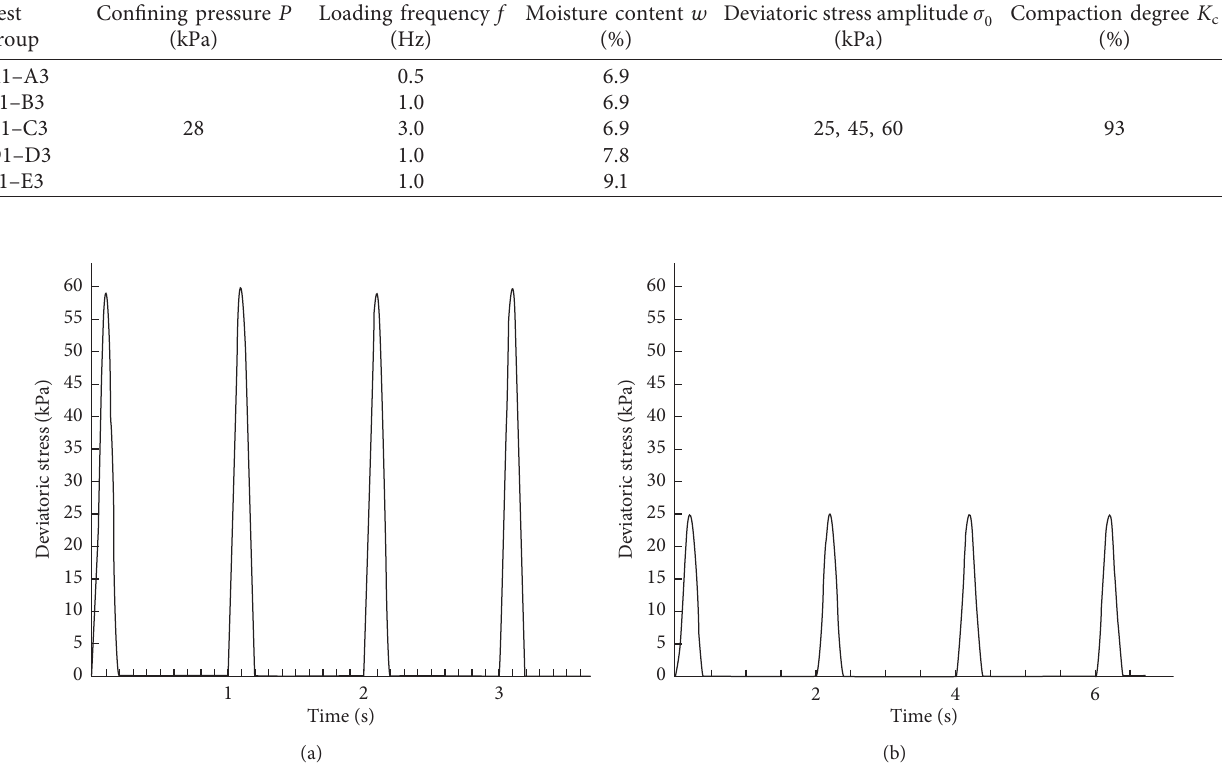
Figure 4: Cyclic loading curves for dynamic triaxial tests. (a) σ